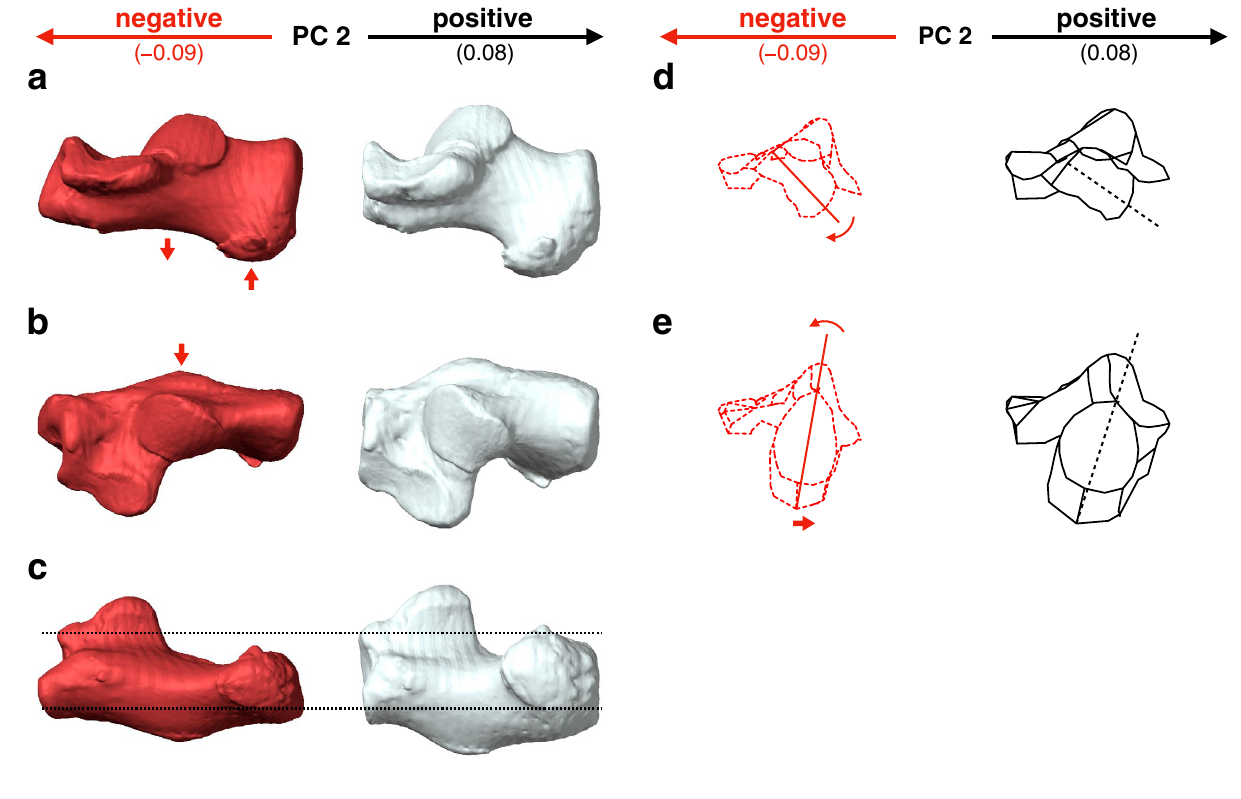
Figure 4. Shape variations represented by PC2 in the whole-sample analysis. Shape variations are visualized using the wireframe connecting primary landmarks and the template surface deformed using a thin-plate spline function. Black line and white surface: PC2 = 0.08. Red line and red surface: PC2 = − 0.09. Red arrows indicate characteristics of the negative score. The medial ( a ), superior ( b ), inferior ( c ), and posterior views of the anterior ( d ) and posterior ( e ) parts were presented.